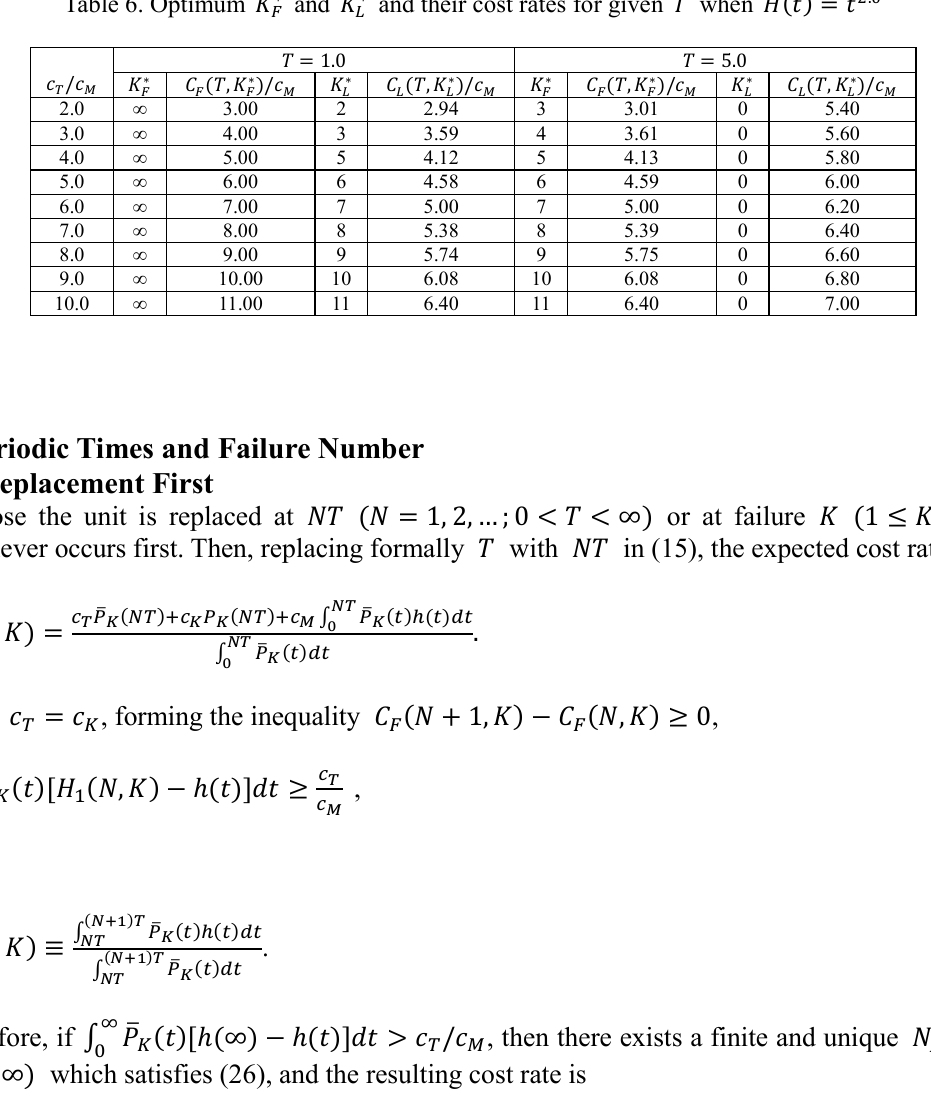
Table 6. Optimum 𝐾 𝐹∗ and 𝐾 𝐿∗ and their cost rates for given 𝑇 when 𝐻(𝑡) = 𝑡 2.0